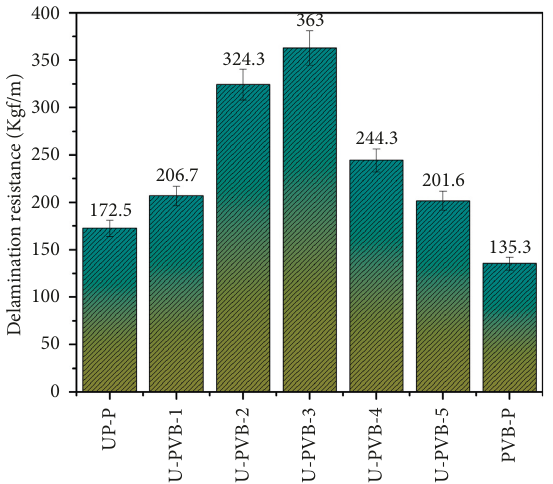
Figure 10: Change in delamination resistance with respect to increase in the PVB